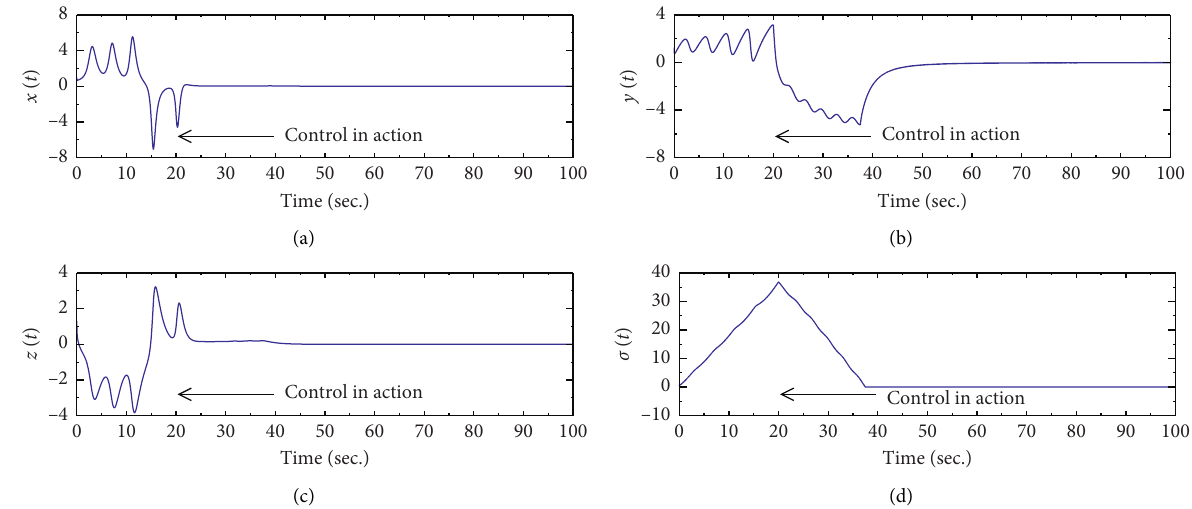
Figure 12: The time series of the controlled commensurate fractional-order system state variables and corresponding time series of the sliding surface with uncertainty and external disturbance (the control input is activated at t � 20